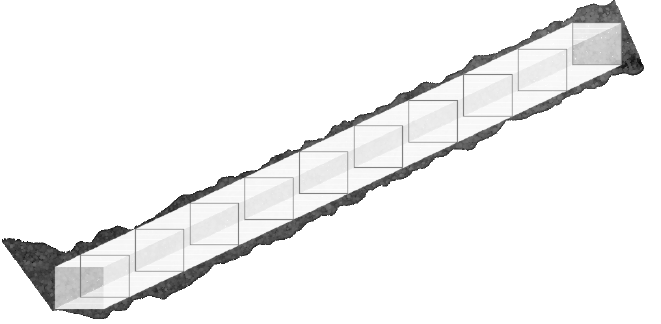
Figure 12. The trajectory with all template windows superimposed in translucent white. Intermediary non-overlapping contours are emphasized for better